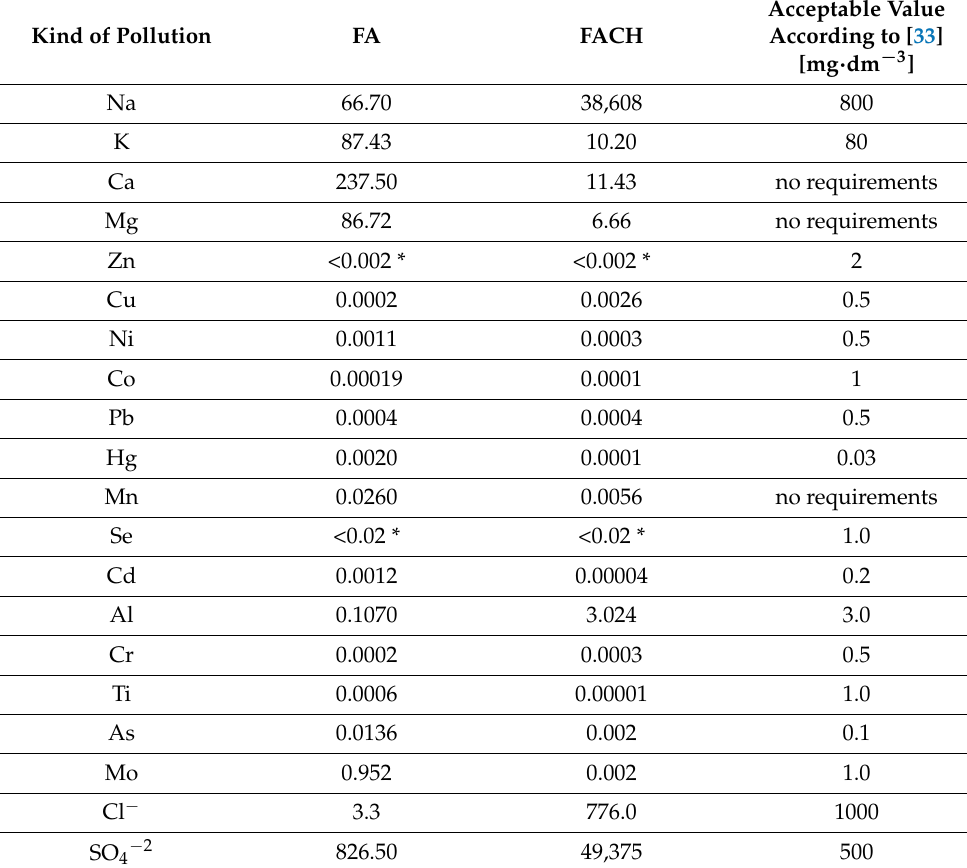
Table 2. Leachability of chemical contaminants from